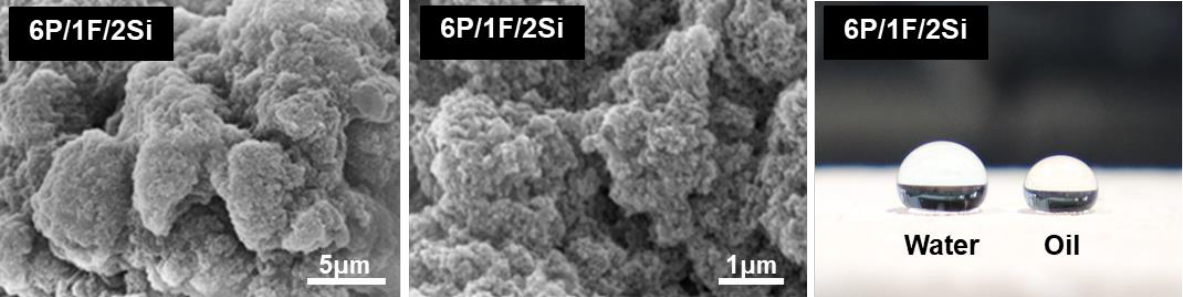
Figure 6. High magnification SEM images of the 6P/1F/2Si coating. A photograph showing a water and oil drop on the 6P/1F/2Si surface is included.